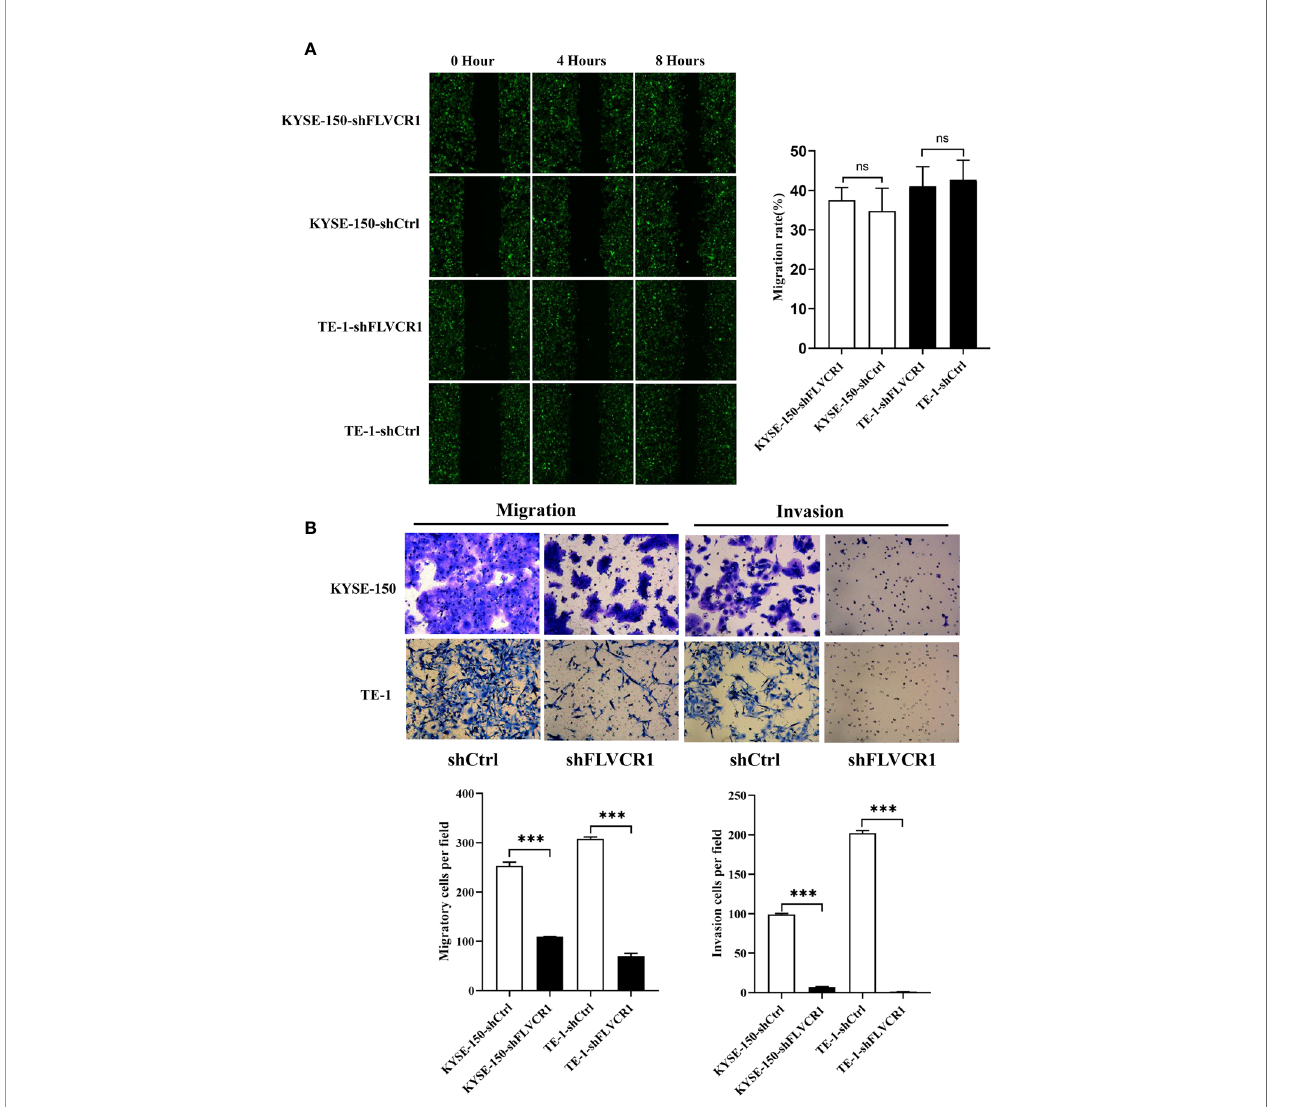
FIGURE 3 | Knockdown of FLVCR1 decelerates ESCC cell migration and invasion. (A) Wound healing assay showed that inhibition of FLVCR1 did not signi fi cantly affect the motility of ESCC cells at 8 hours. (B) Transwell assays revealed that knockdown of FLVCR1 attenuated cell migration at 20 hours and reduced cell invasion at 48 hours. ***P < 0.001; ns, no signi fi